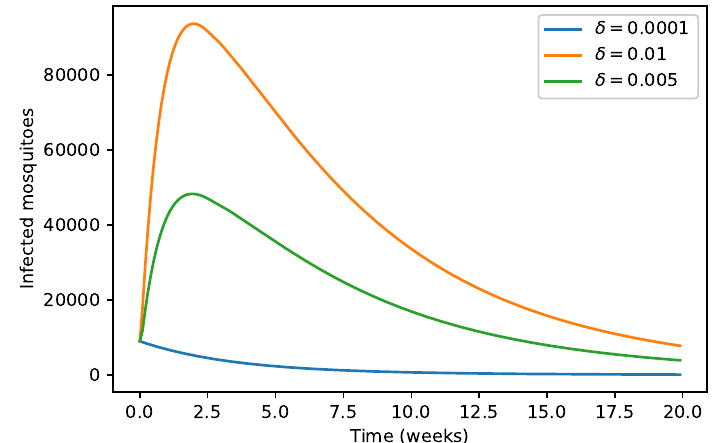
Figure 8. Variation of infected mosquitoes population with respect to δ